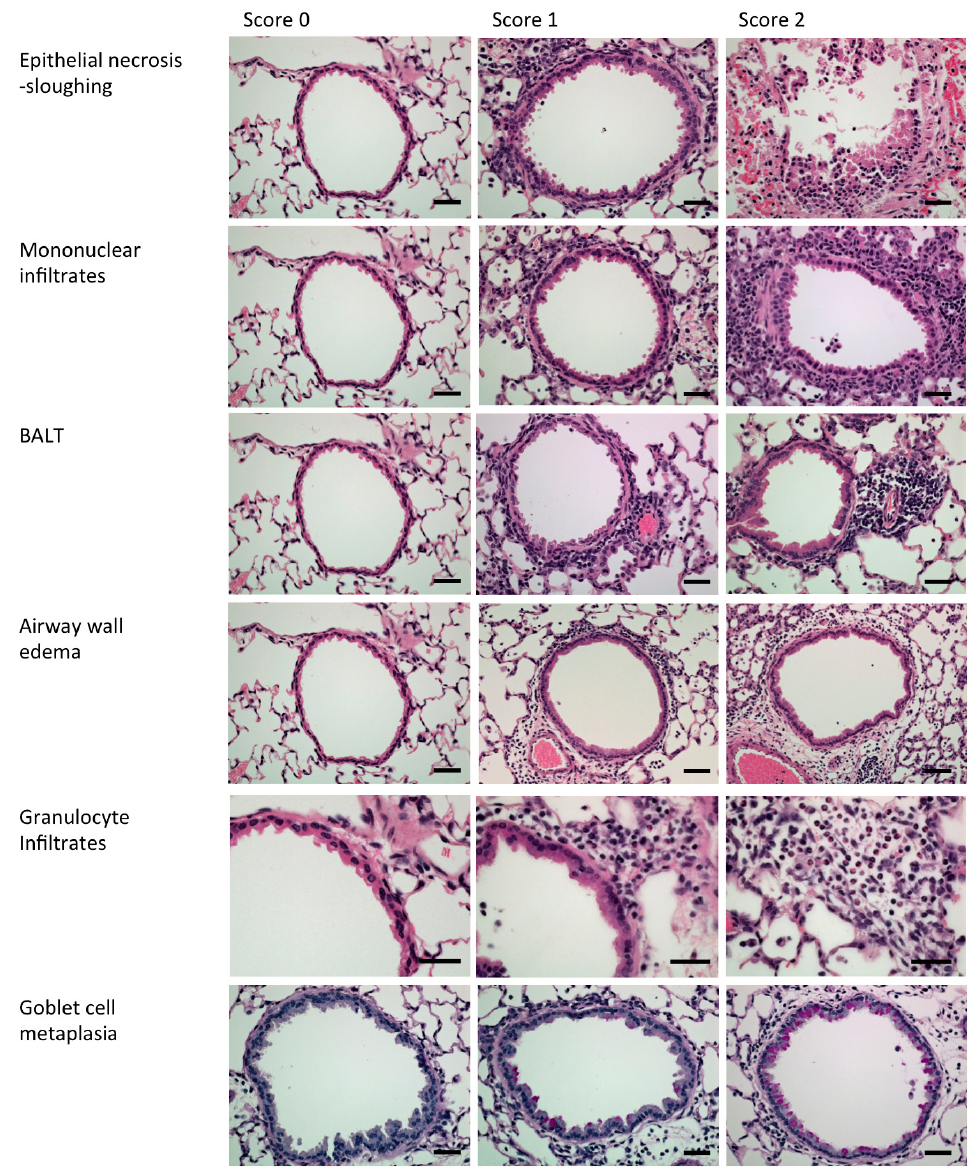
Figure 2. Examples used to generate an airway inflammation histological score in mice. Hematoxylin and eosin staining (top five rows). Periodic acid–Schiff (PAS) staining (bottom row). Scale bars represent 100 μ m. BALT: bronchus-associated lymphoid tissue.